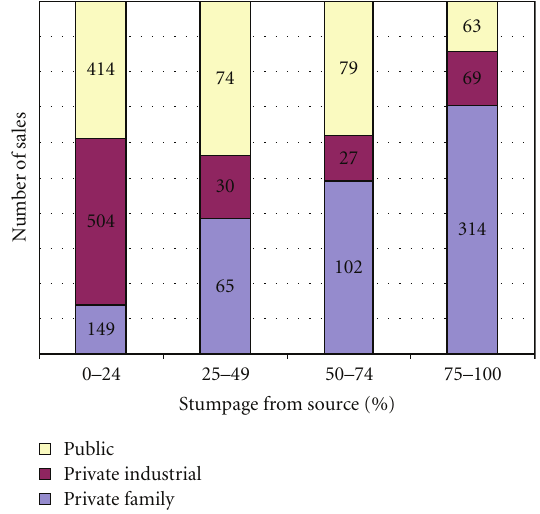
Figure 1: Source of timber supply from private family, private in- dustrial, and public forestlands as indicated by firms in the study